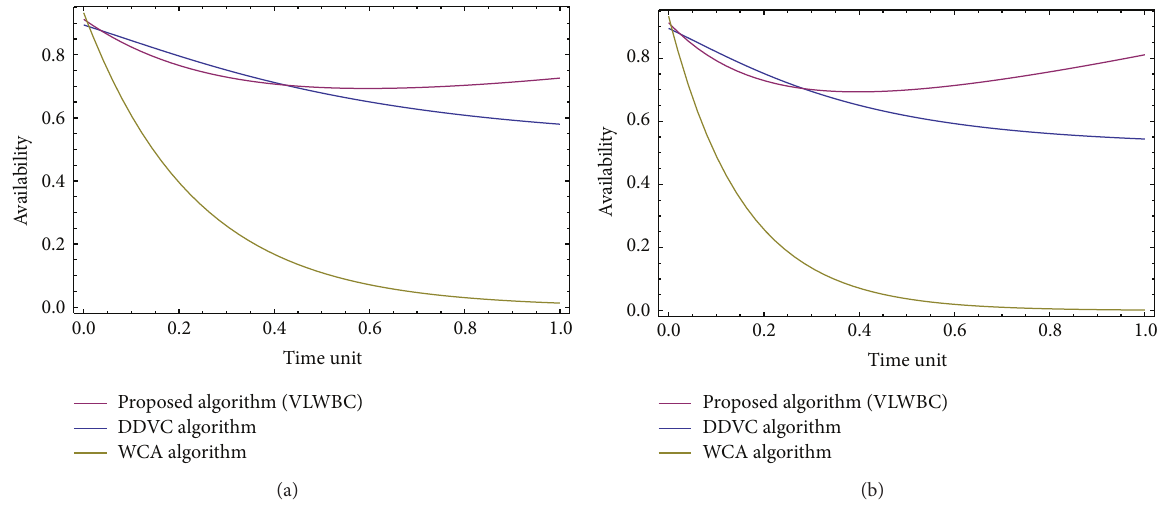
Figure 9: VLWBC algorithm availability when (a) 𝜆 = 0.2 and (b) 𝜆 = 0.4 .